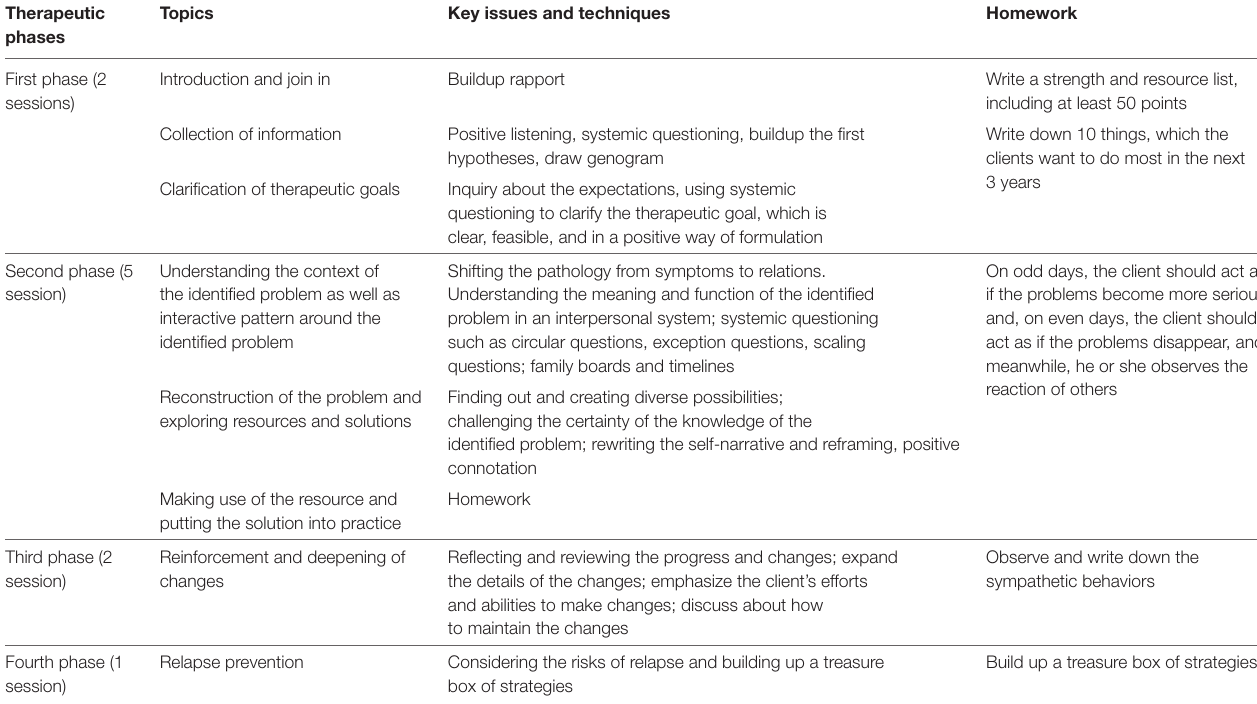
TaBle 1 | Topics and key concepts of systemic